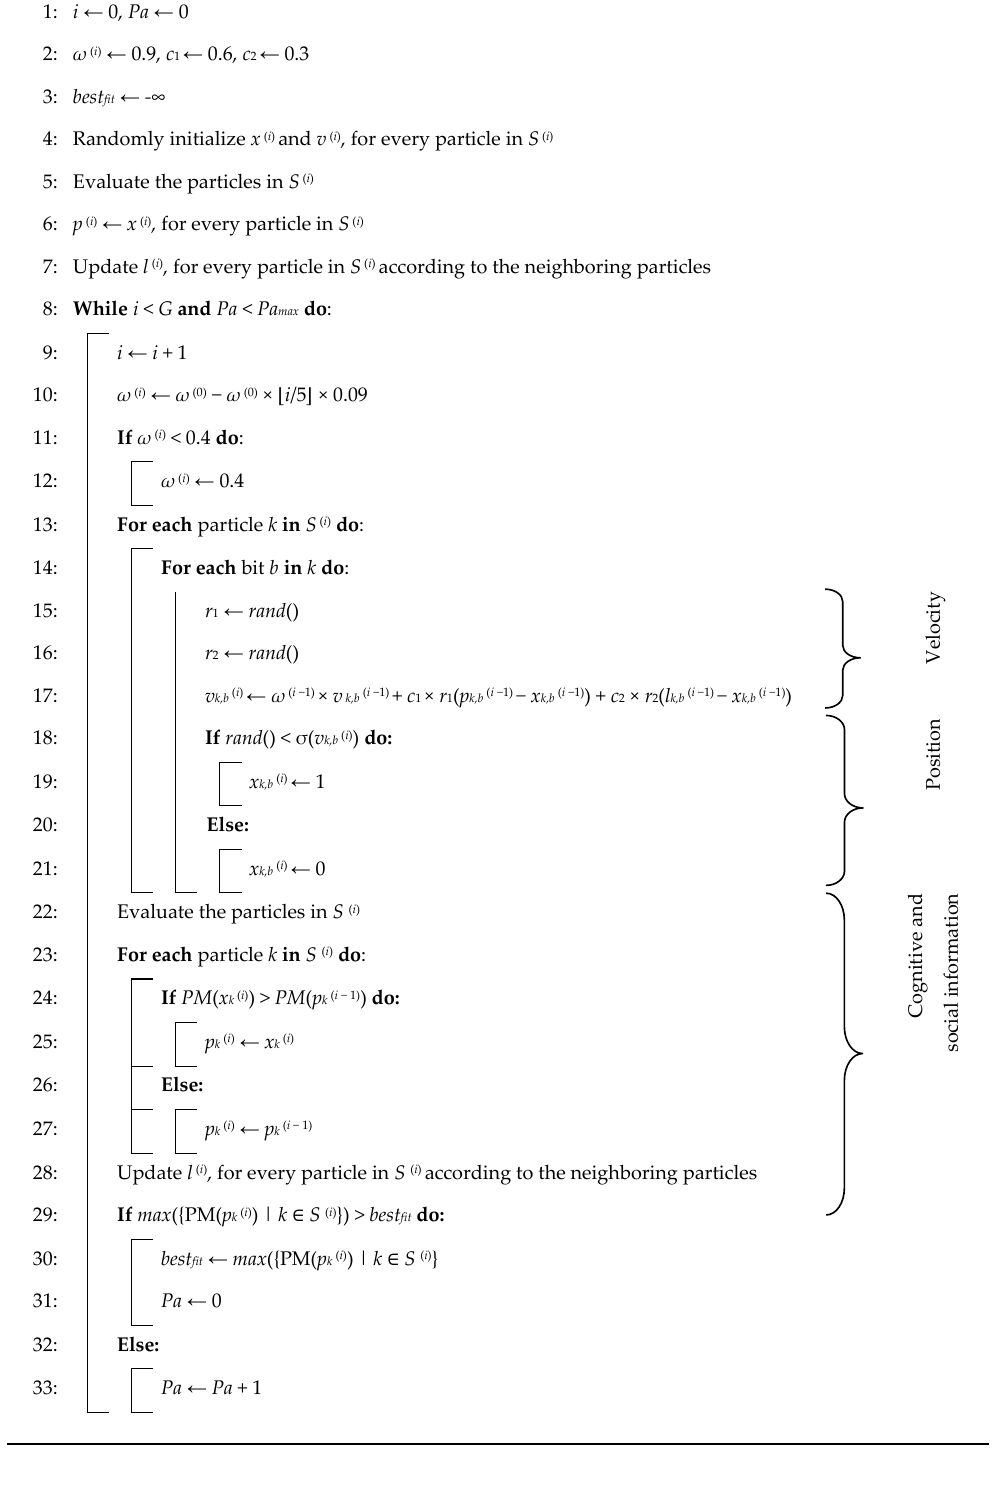
Algorithm A2. Pseudocode for the PSO algorithm variant used in this work.